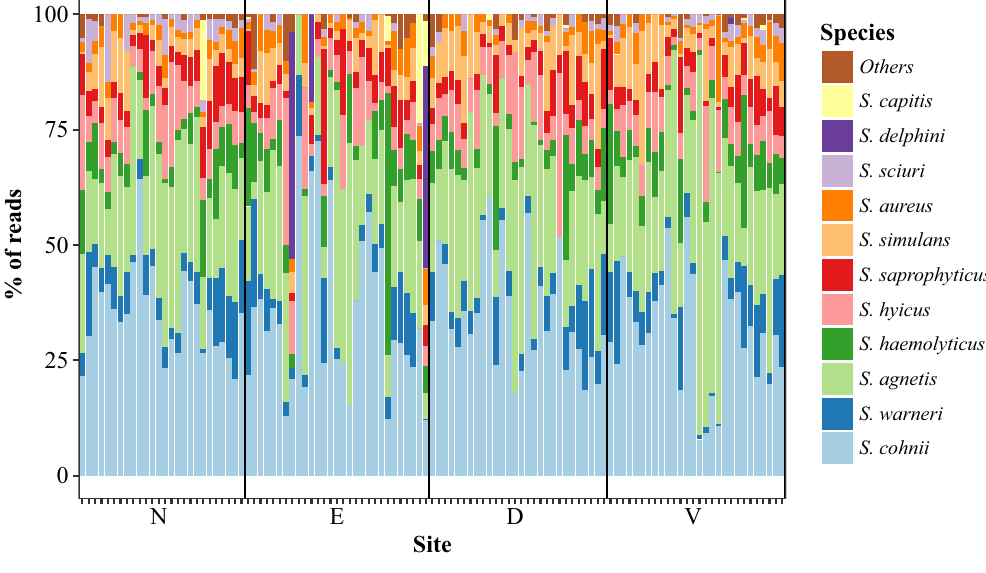
Figure 5. Composition of pig samples using tuf gene primers with S. equorum subtracted. Each column corresponds to a single sample in which the relative abundance of bacterial genera is shown through color coding. N: nose, E: ear, D: dorsal skin surface, V: ventral skin